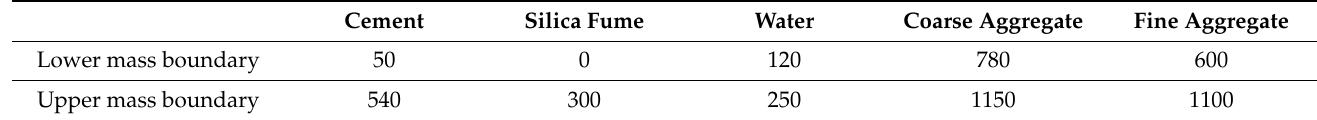
Table 2. Upper and lower mass boundaries of concrete components.